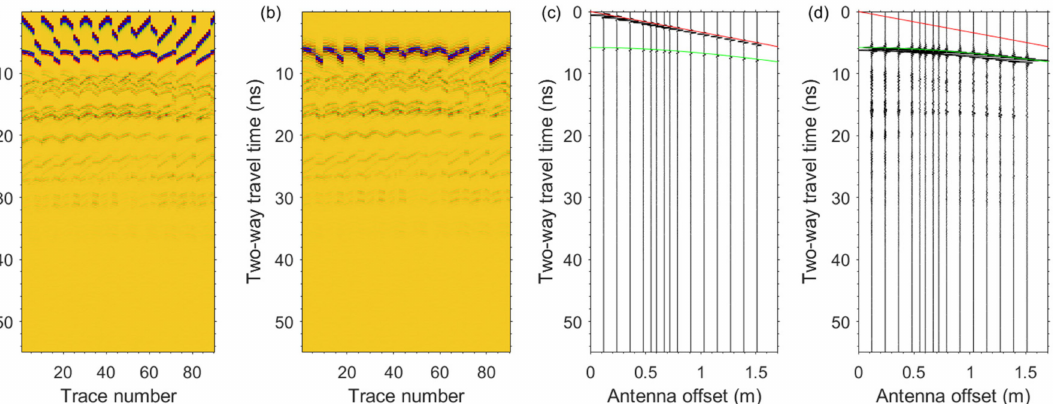
Figure 8. ( a ) Radargram of raw data simulated by FDTD. ( b ) Modeled data after bandpass filtering and background removal. ( c ) Wiggle form of the simulated raw data. ( d ) Wiggle form of the simulated raw data after bandpass filtering and background removal. The red and green lines indicate the theoretical arriving time of direct waves and ground-reflected waves. The simulated raw data and data after processing are comparable with the lunar data shown in Figure 4.